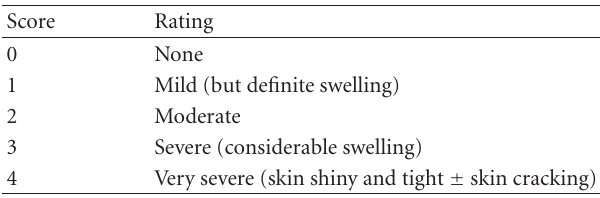
Table 1: Stern’s Rating Scale for Edema